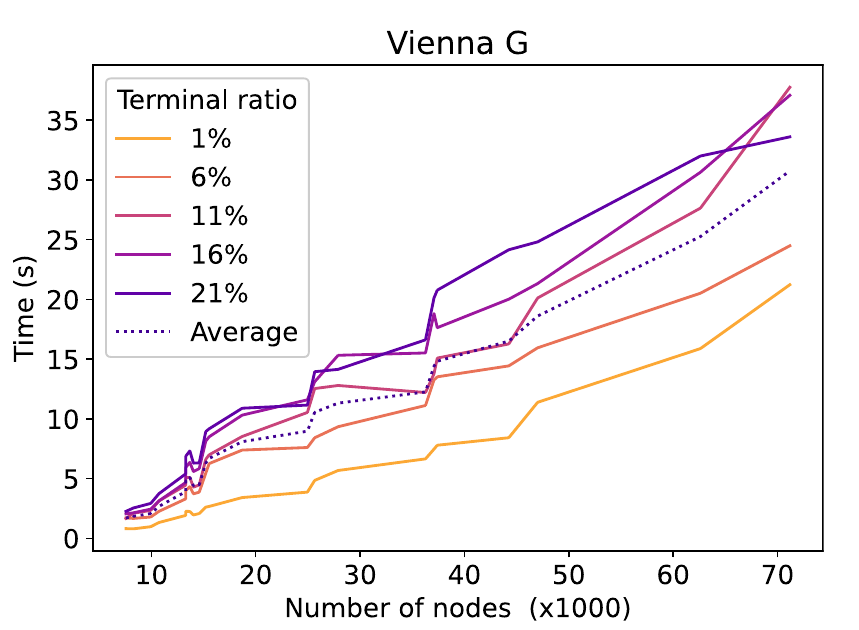
Fig 8. Vienna G CSPH time evolution by terminal ratio. The time in relation to the number of nodes. For each line, a different percentage of nodes is a terminal.